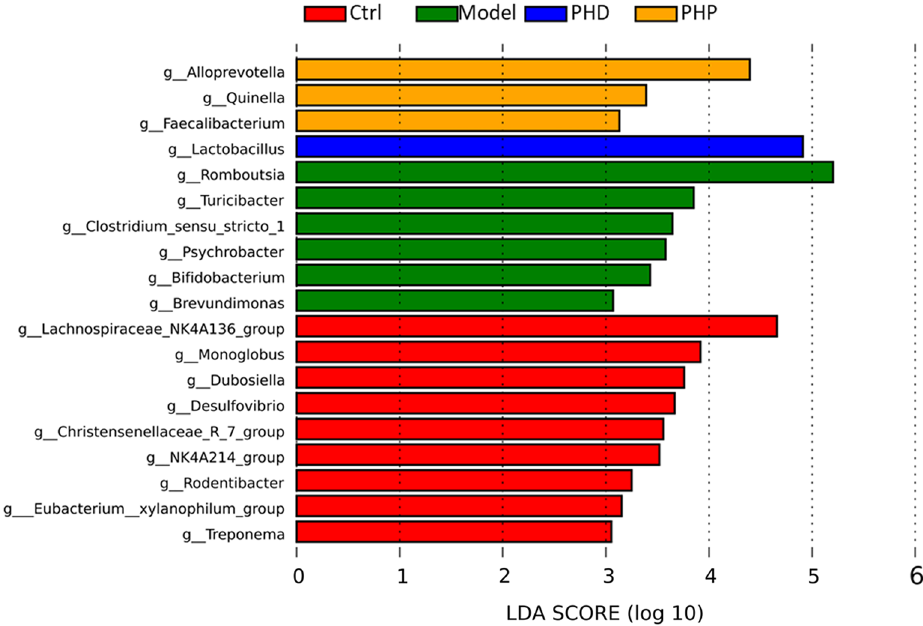
Figure 8. LDA score histogram of four groups (only taxa with LDA score higher than 3 were